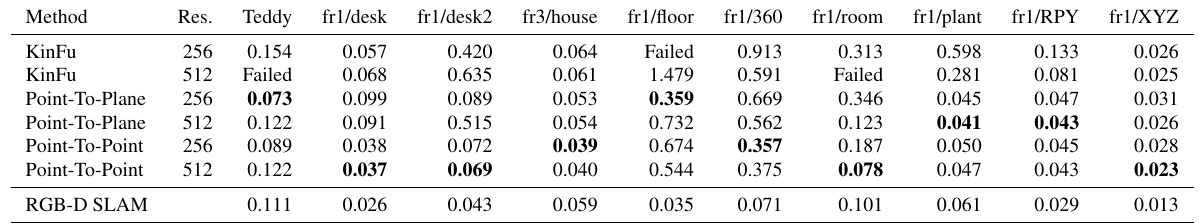
image from the SDF that it then aligns to the current depth im- age using the iteratively closest point algorithm (ICP). As this